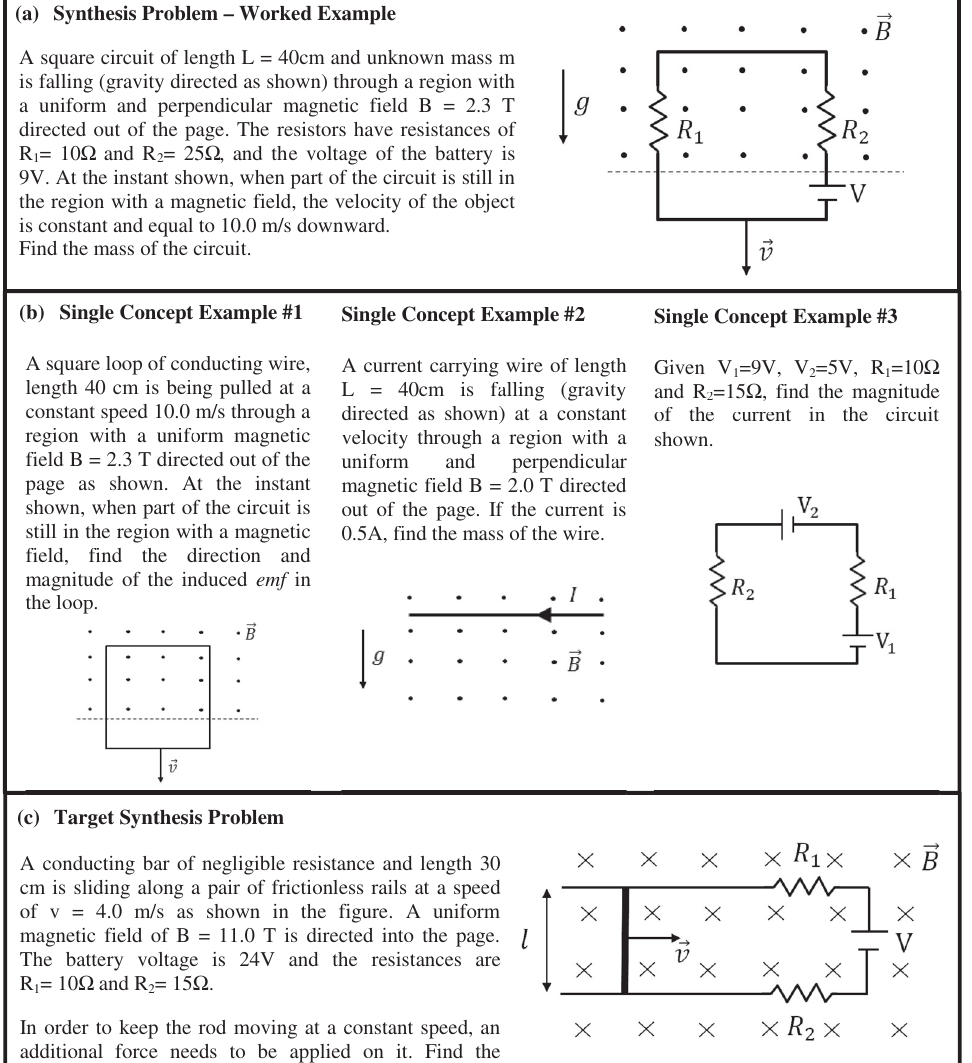
FIG. 5. An example synthesis problem provided as a worked example (a), corresponding single concept problems (b), and the target synthesis problem